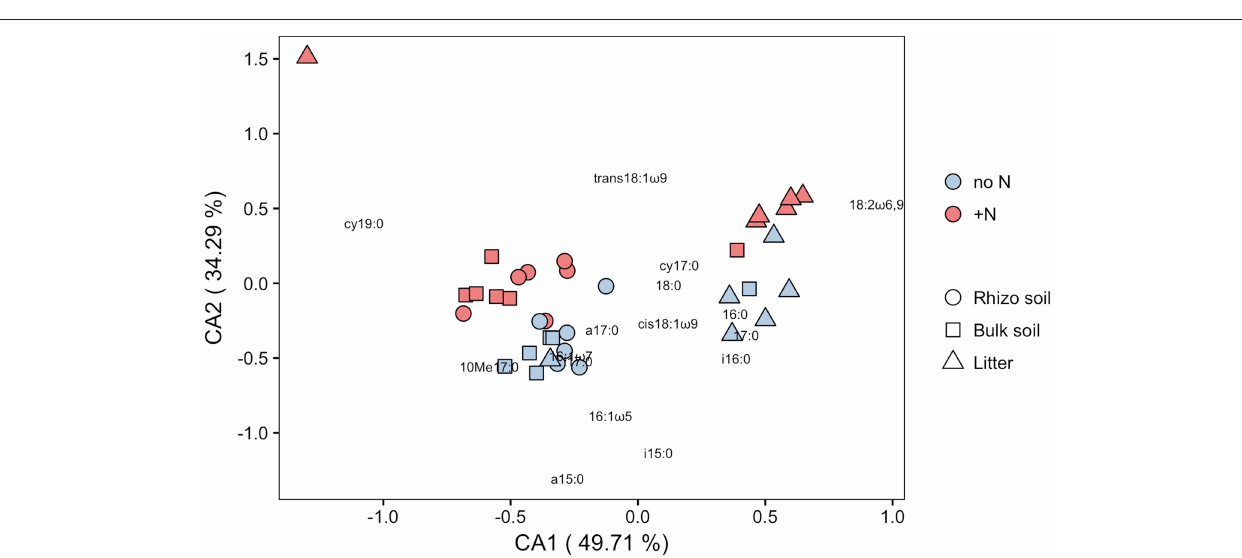
FIGURE 9 | Correspondence analysis (CA) of C in PLFAs ( µ g C g − 1 dry weight) in N-treated and untreated compartments of dual-labeled ( 13 C and 15 N) plant boxes. Close distances between individual PLFAs (depicted as text) and soil/litter-pools of individual split-root boxes (depicted as symbols) indicate higher abundance of respective PLFAs in concerned pools. Axes notations give the proportion of variance explained on each coordinate in percent. Colors refer to box-sides with untreated (no N) and N-treated ( + N) litter compartments. ANOSIM analysis shows significant difference between pools ( R = 0.566, p = 0.001) as well as between N-treatments ( R = 0.103, p = 0.011). This analysis indicates (i) a distinctly different microbial community between soil pools (rhizosphere soil, bulk soil) and litter, and (ii) that N addition affects not only community structure in hyphae-only litter compartments, but also in soil compartments (cf. Figure 8